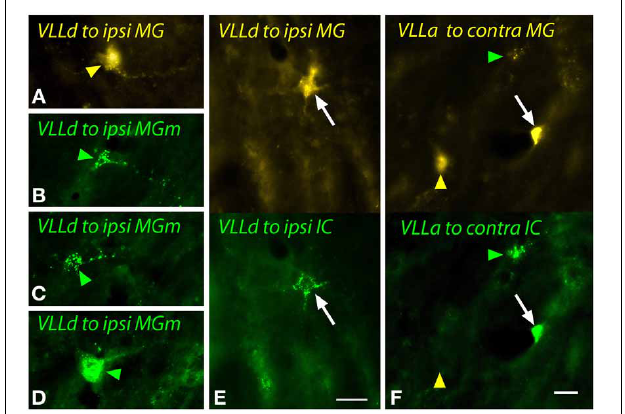
FIGURE 10 | Photomicrographs showing labeled cells in the dorsal (VLLd) and anterior (VLLa) subdivisions of the ventral nucleus of the laterallemniscusafterinjectionsintothemedialgeniculatenucleus(MG) and the inferior colliculus (IC). (A) Cell in the left VLLd labeled after a large injection of FluoroGold into the left MG (GP597). (B–D) Cells in the right VLLd after injection of green beads into the right MG medial subdivision (MGm; GP689). (E) Double-labeled cell (white arrow) in the left VLLd after injections of FluoroGold into the left MG and green beads into the left IC (GP597). (F) Single-anddouble-labeledcellsintherightVLLaafterinjectionsofFluoroGold into the left MG and green beads into the left IC (GP597). The upper half shows the cells labeled with FluoroGold and the lower half shows the same area imaged to show green beads. Labeling patterns included double-labeled cells (white arrow) as well as cells that contained only FluoroGold (yellow arrowheads) or only green beads (green arrowheads). Scale bar = 20 µ m and applies to all panels. Transverse sections; dorsal is up; lateral is to the left (A,E,F) or right (B–D) . Abbreviations: contra, contralateral; ipsi,